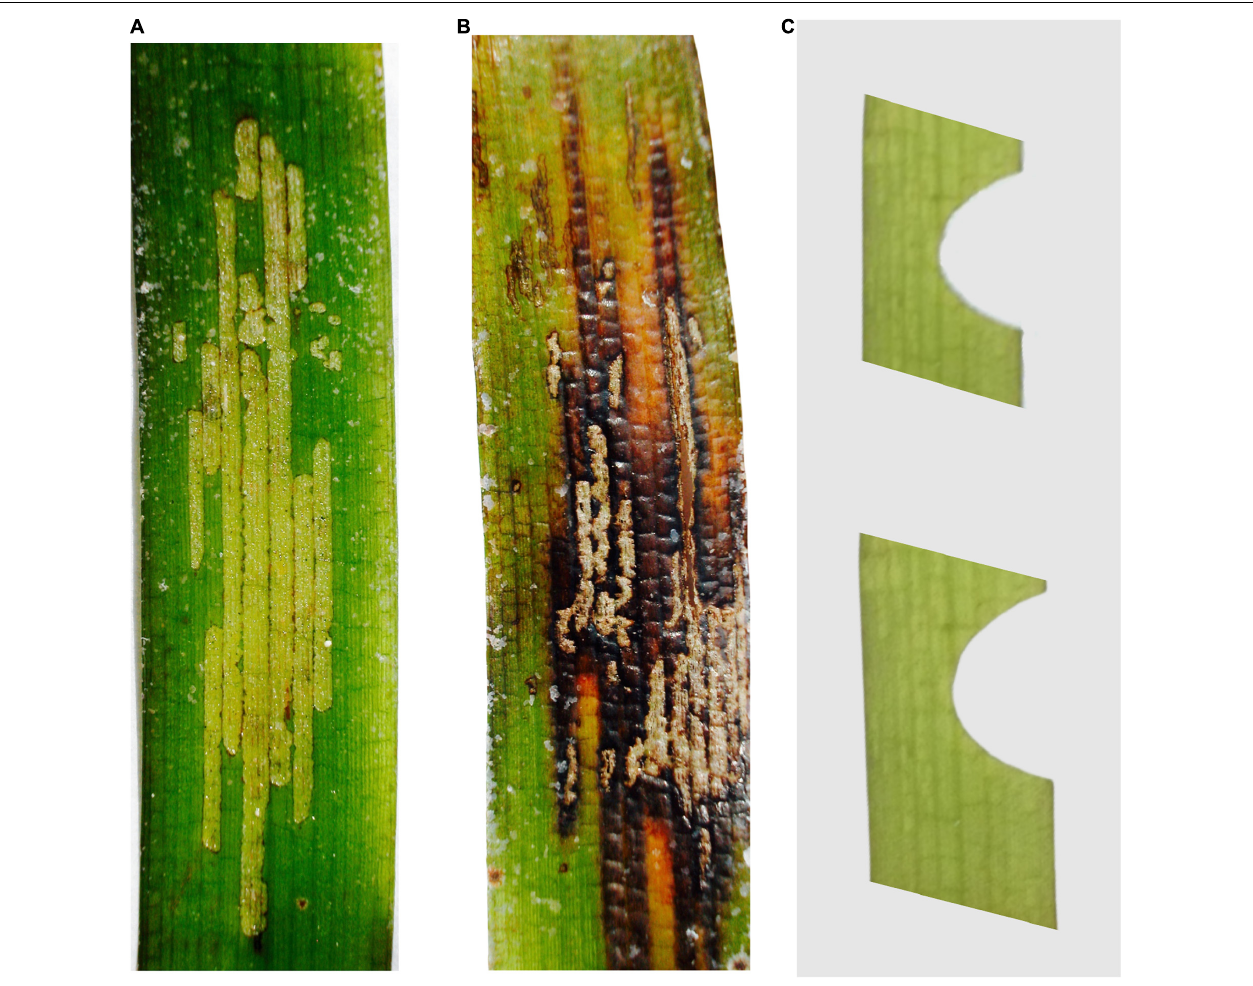
FIGURE 1 | (A) Fresh grazing scars found on turtlegrass ( Thalassia testudinum ). (B) The onset of fungal infection as a result of grazer-induced scars on turtlegrass ( Thalassia testudinum ). (C) Turtlegrass blades after being wounded with a hole-punch for the simulated herbivory experiment. Images are courtesy of BS, Duke